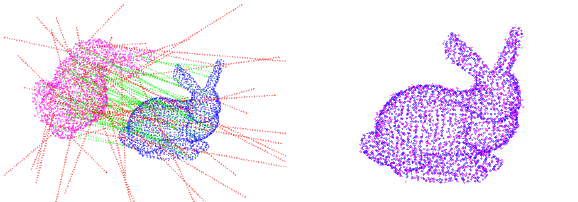
Figure 2: Point cloud registration for the Stanford Bunny. Green and red lines represent inlier and outlier correspondences,